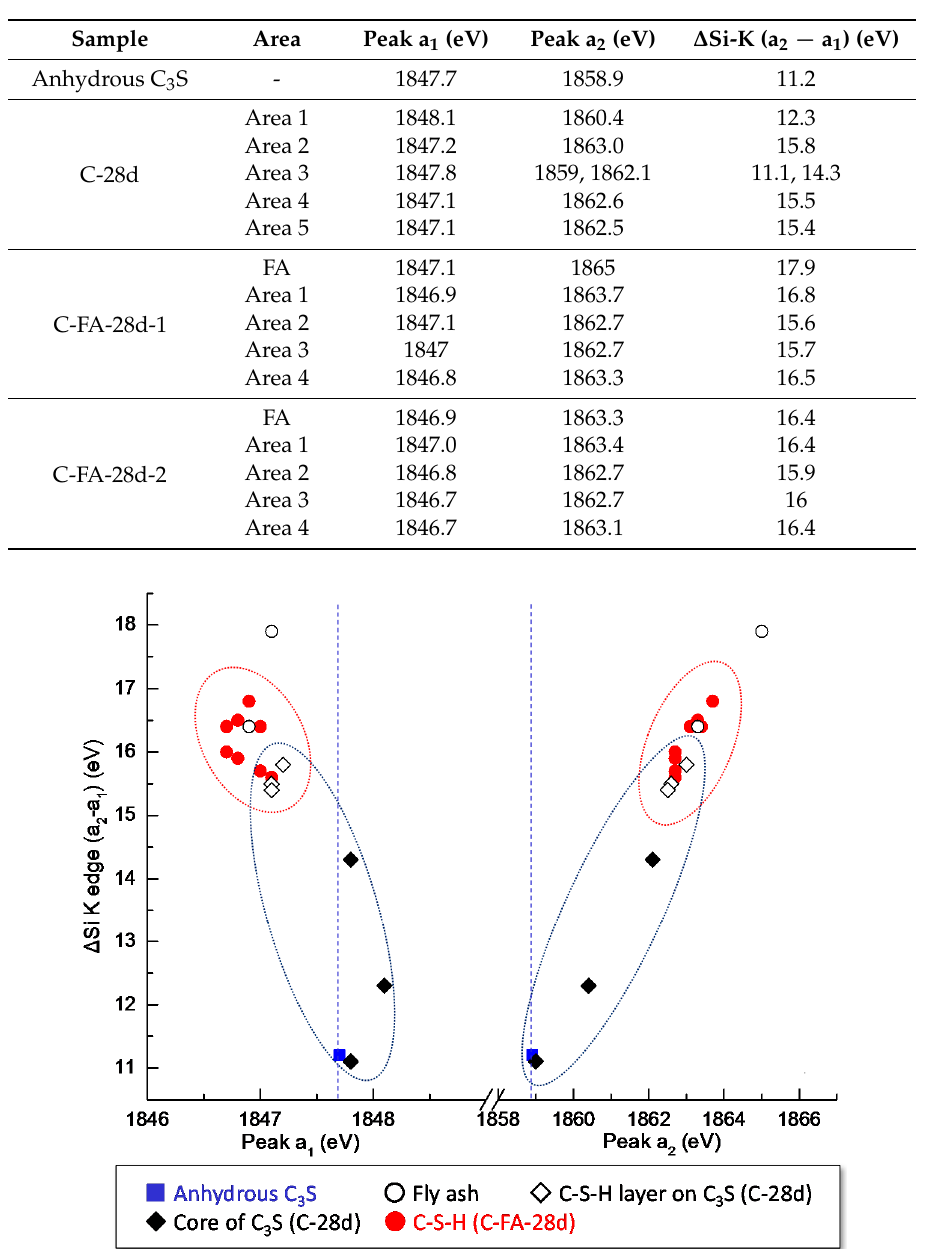
Table 3. Si K edge peak positions and energy separation values.